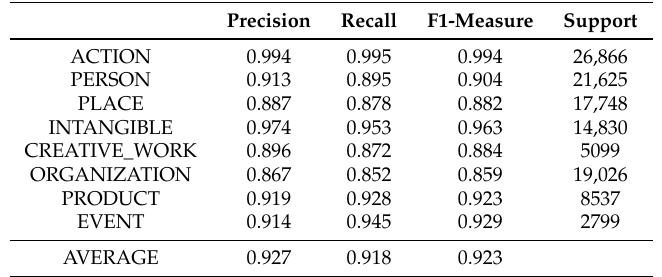
Table 4. Results with use of hyper-parameter optimization and cross